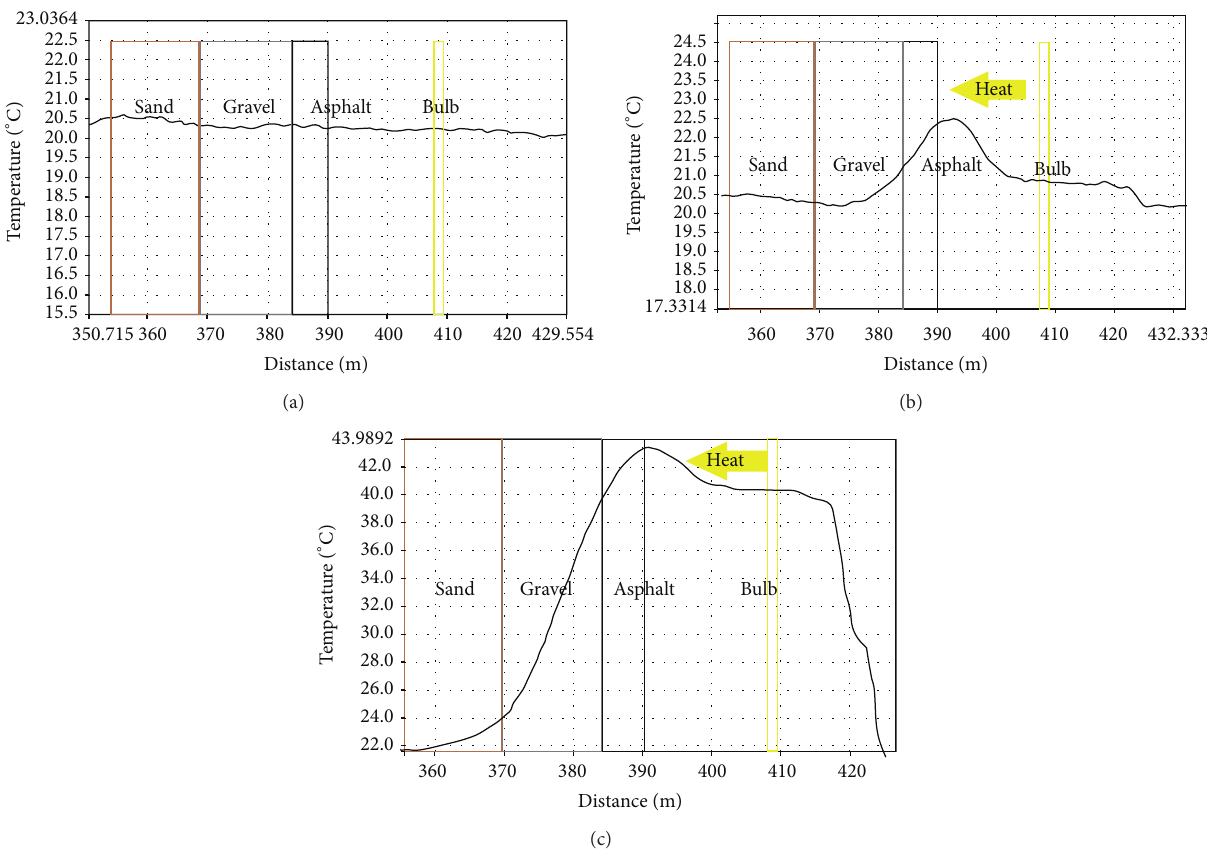
Figure 7: (a) The temperatures of sand, gravel, and asphalt layers are approximately at the room temperature before the heating starts (time stamp of data: 15.1.2013, 8:00; room temperature 20.06 ∘ C). (b) Four minutes after heating starts, warming of asphalt layer surface is clearly observed and thermal gradient is formed (time stamp of data: 15.1.2013, 8:20; room temperature 20.25 ∘ C). (c) The sand layer is also warmer after the heating period of 5 hours and 4 minutes (time stamp of data: 15.1.2013, 13:20; room temperature 20.57 ∘ C).